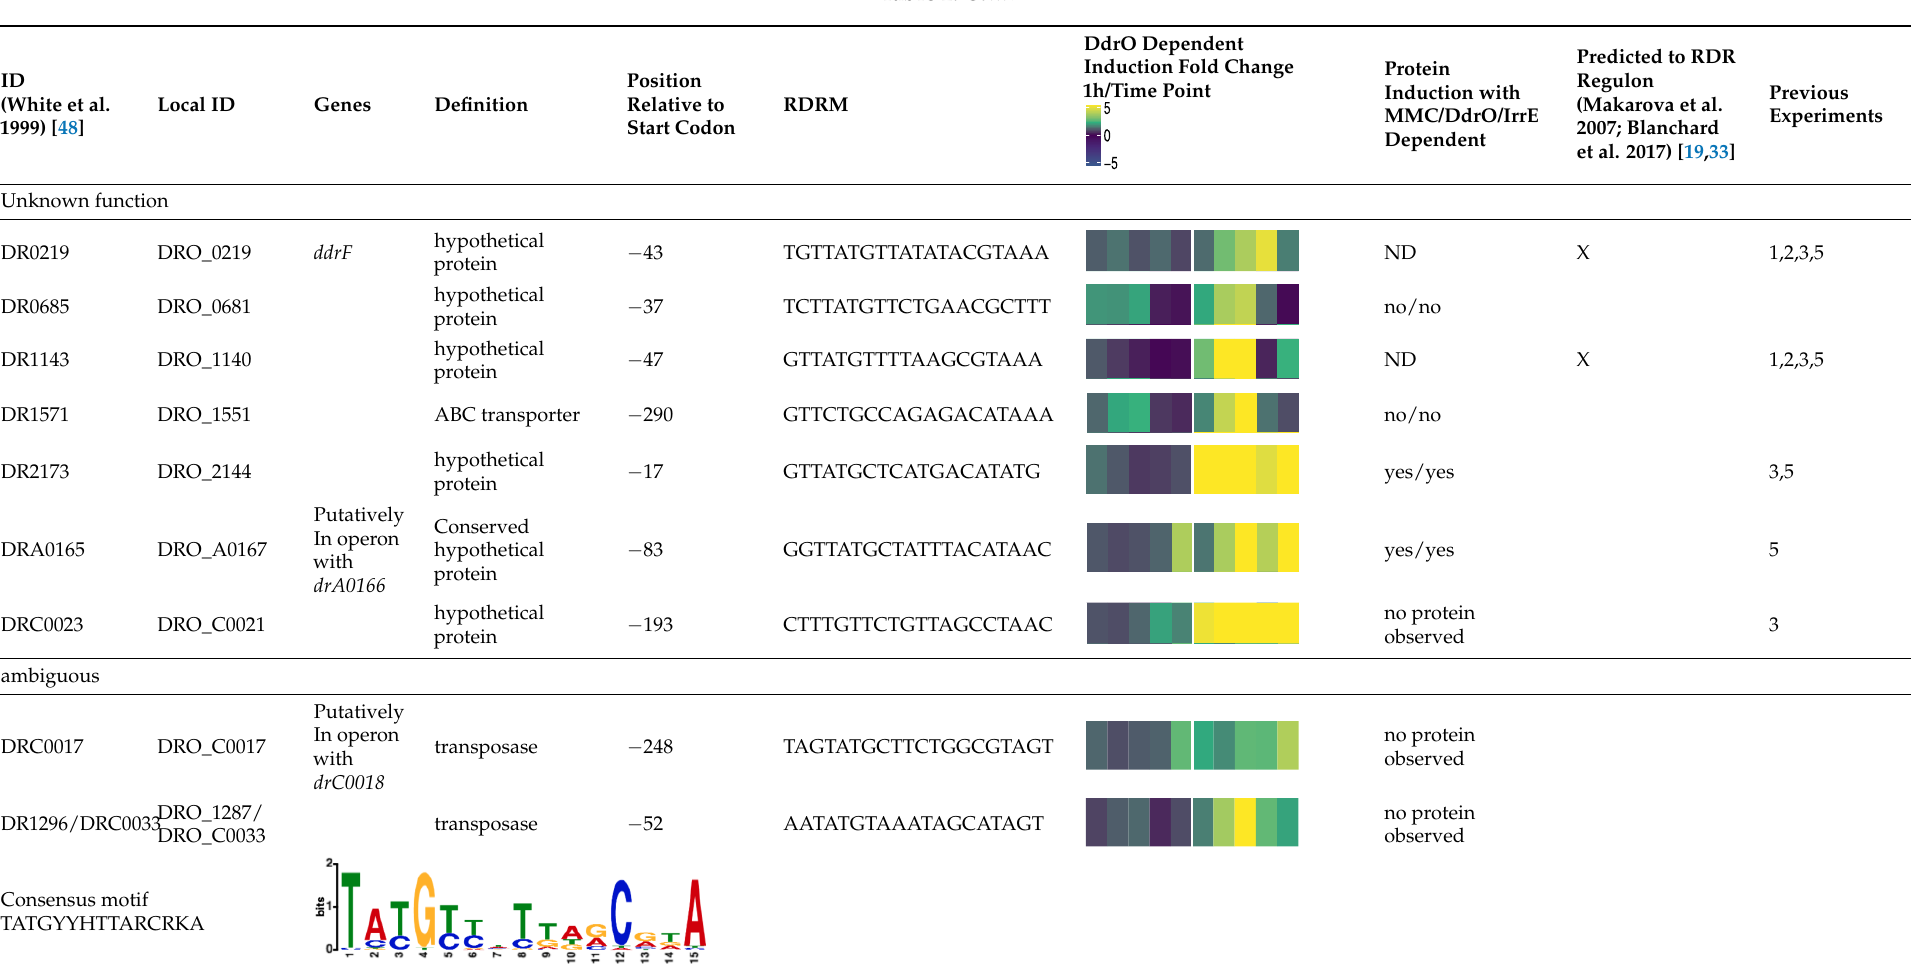
Table 2. List of genes belonging to the DdrO regulon in D. radiodurans matching all criteria (transcriptomic, ChIP-seq, and RDRM). Previous experiments: (1) RDR genes previously predicted by bioinformatic analyses [19,33] (2) by in vitro EMSA assays which analyzed the binding of DdrO to RDRM sequences located in the promoter regions of these genes [26] or shown to be regulated after exposure to radiation by (3) transcriptomic [12], (4) proteomic studies [54], or (5) in a ∆ irrE mutant [24]. Logo of the RDRM consensus performed by MEME from all the RDRM sequences listed in Table 2. ND: Not Table 2. Cont.